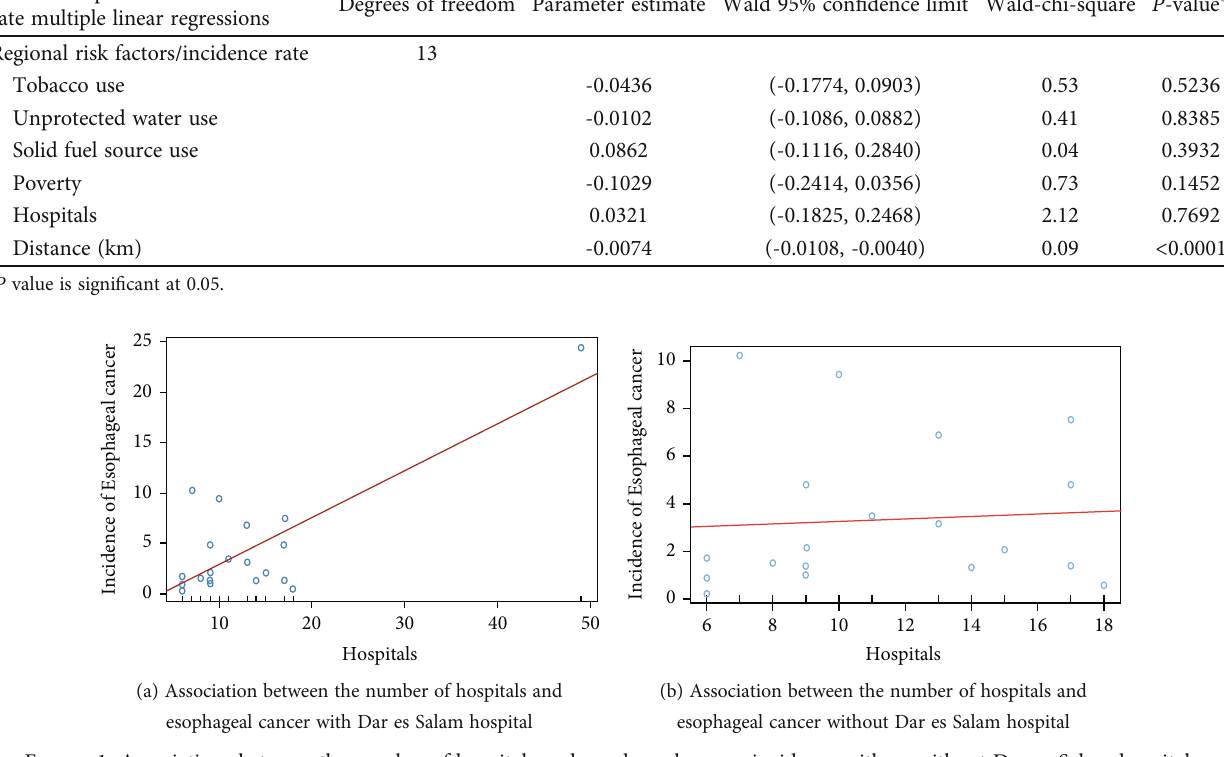
Table 7: Poisson regression for the association between prevalence of etiologic risk factors for esophageal cancer and distance with incidence rate.